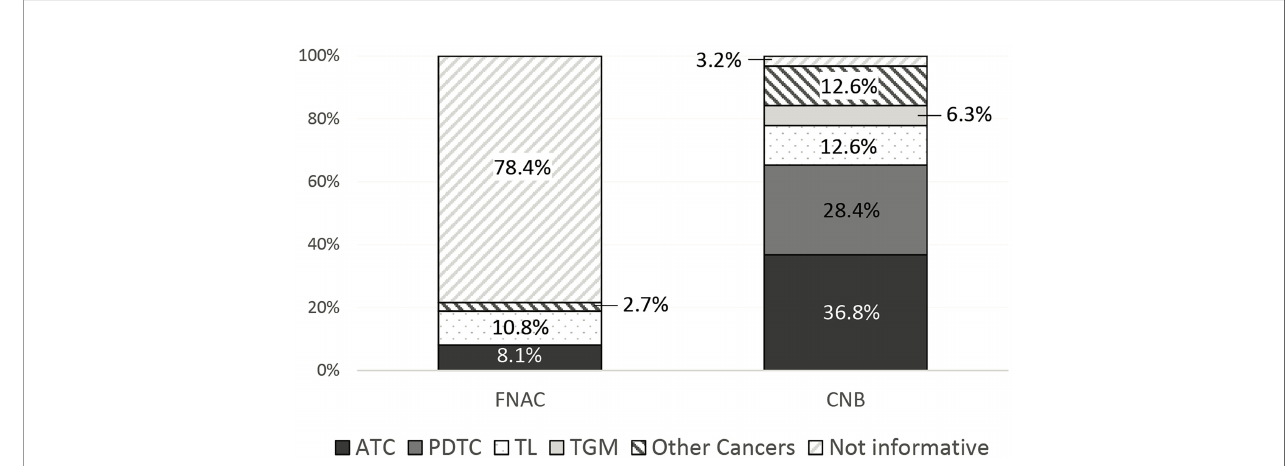
FIGURE 2 | Diagnostic ability of fi ne needle aspiration cytology (FNAC) and core needle biopsy (CNB) in identifying tumor